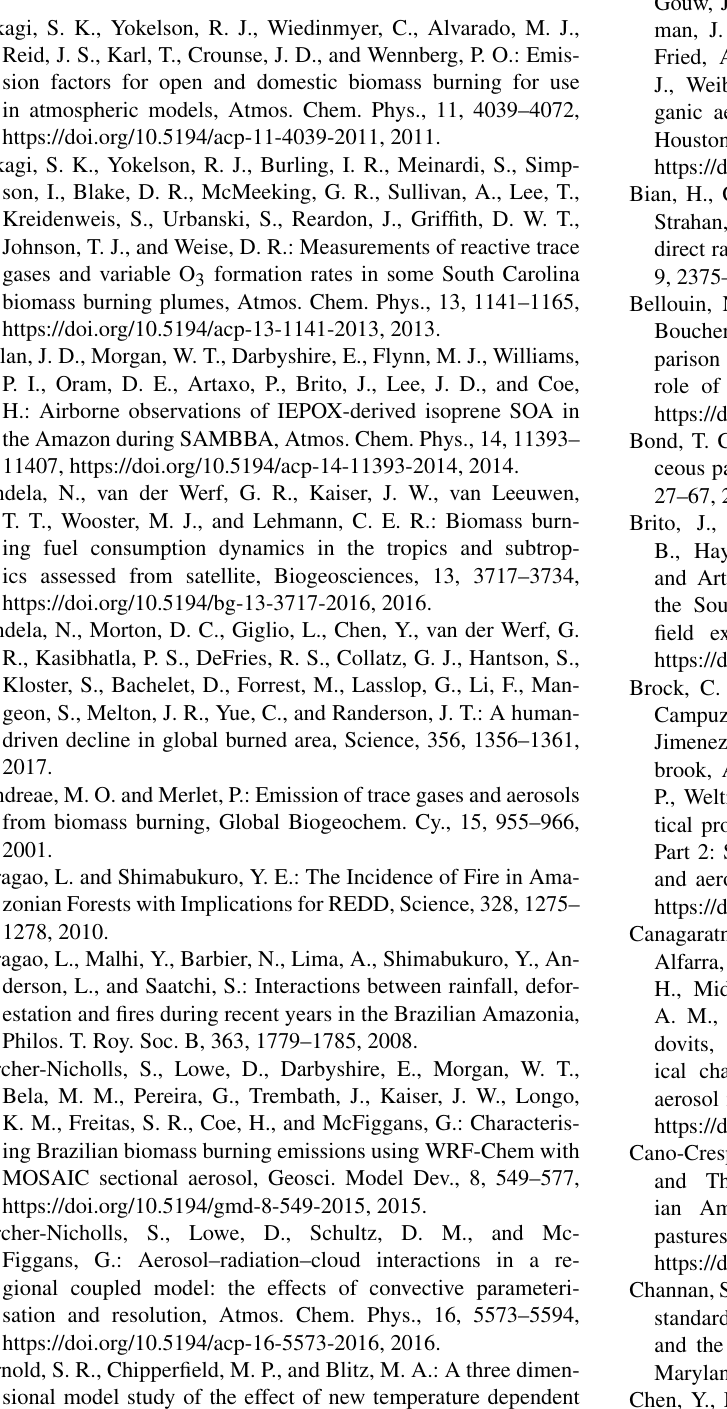
sional model study of the effect of new temperature